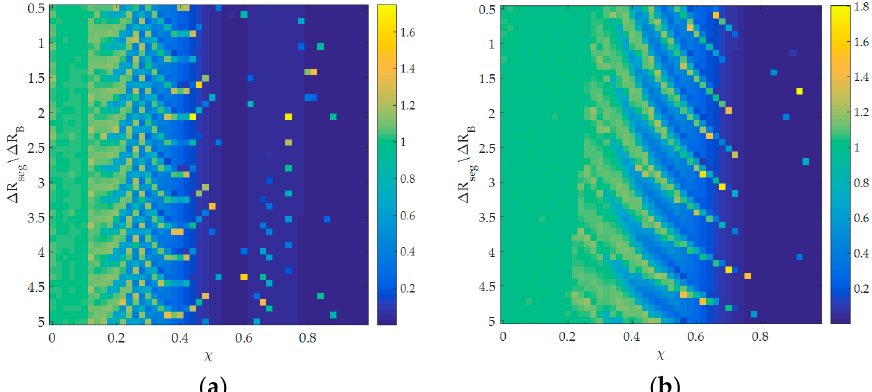
Figure 20. The simulated relative phase ∆Φ against χ and ∆ R seg . ( a ) and ( b ) correspond to targets T 3 in position A and position D in Table 2, respectively. These two images reflect the corner points’ P M phase error of controlled by ∆ R seg and χ . ∆Φ heavily relies on χ , which means the azimuth spatial variance is more severe than in the range direction. This was verified by imaging results in Figure 16g,h. From the simulation results, χ should be larger than 0.8, whereas ∆ R seg can be several times ∆ R B with high ∆Φ values avoided.